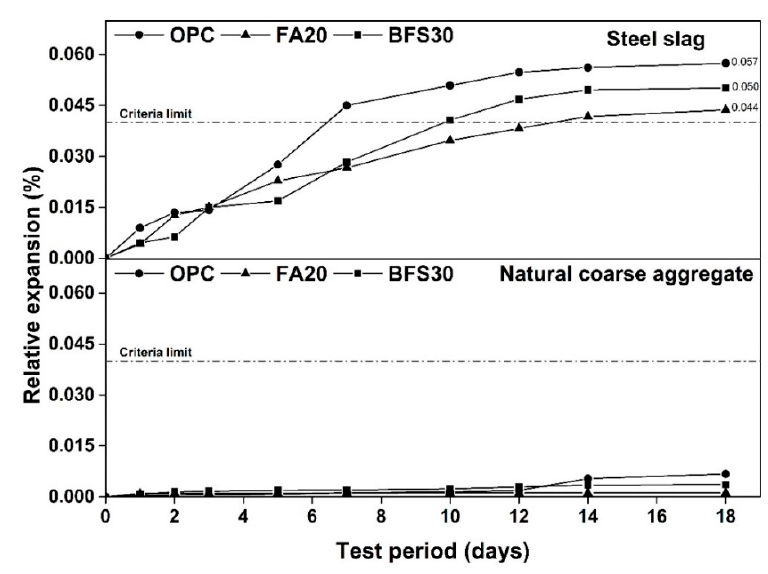
Figure 4. Results of ASR expansion (concrete specimens).